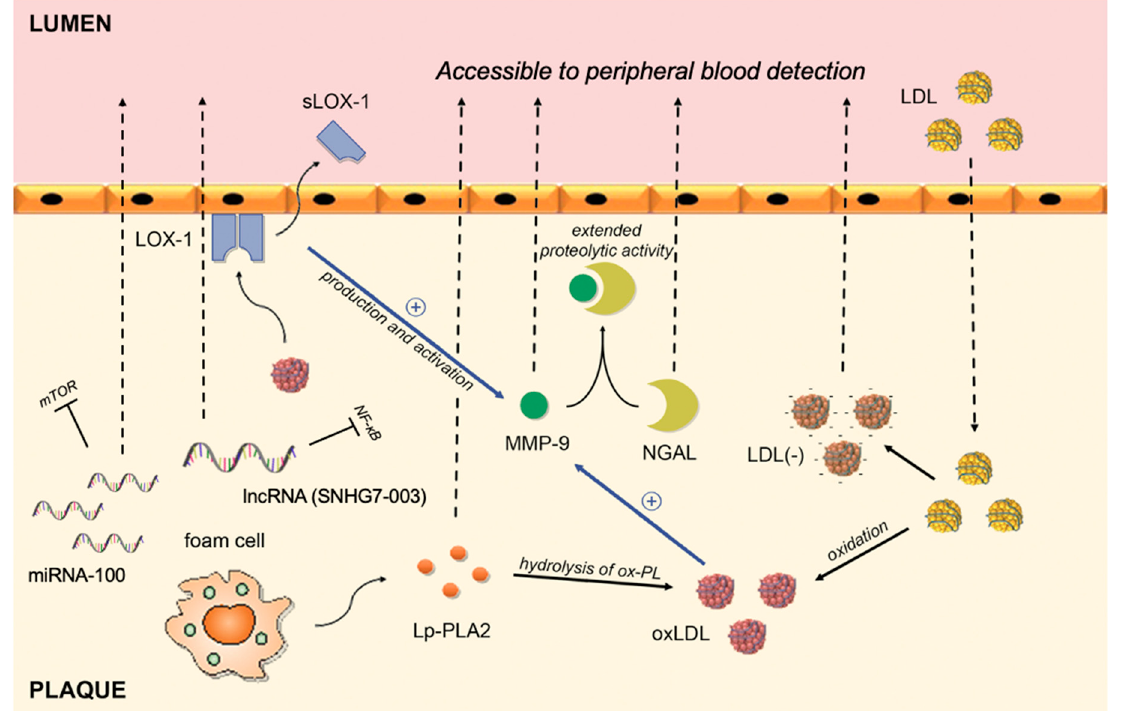
Figure 1. Circulating biomarkers of vulnerable plaques and their interplay in the intima of the coronary artery. LDL migrates from blood to plaque, where it goes through series of modifications. By binding to LOX-1, oxLDL activates and upregulates the production of MMP-9, whereas shedding of the LOX-1 receptor allows its peripheral blood detection. The complex between NGAL and MMP-9 results in extended proteolytic activity of MMP-9. Lp-PLA2 is responsible for hydrolysis of ox-PL on LDL particles and subsequent release of proinflammatory lipids. MMP-9: Matrix metalloproteinase-9; NGAL: Neutrophil gelatinase-associated lipocalin; sLOX-1: soluble part of the Lectin-like oxidized low-density lipoprotein receptor-1; Ox-LDL: oxidized low-density lipoprotein; Ox-PL: oxidized phospholipids; Lp-PLA2: lipoprotein-associated phospholipase A2; LDL(-): electronegative low-density lipoprotein; LDL: low-density lipoprotein; miRNA-100: microRNA-100; lncRNA: long non-coding RNA.